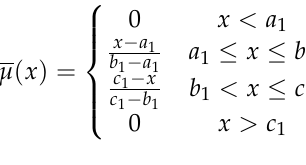
Figure 4. ScaleTriScaleGaussT3MF used in the IT3FDE. The interval type-3 triangular membership function, (cid:101) µ A ( x , u ) = ScaleTriScaleGaussT3MF, with triangular FOU ( A ) , is characterized with parameters [ a 1 , b 1 , c 1 ] (UpperParameters) for upper membership function (UMF) and λ (LowerScale), (cid:96) (LowerLag) parameters for lower membership function (LMF), to form the domain of uncertainty (DOU) with parameters ( u ) characterize the FOU ( A ) , these are IT2-FSs DOU = [ µ ( x ) , µ ( x ) ]. The vertical slices A ( x ) ( u ) with parameters [ σ ( x )] for the UMF and LMF λ (Lower- with Gaussian T2 MF, µ A ( u , m x ) Scale), λ (LowerLag). The (cid:101) µ A ( x , u ) = ScaleTriScaleGaussT3MF(x,{{[a1, b1, c1]}, λ , [ (cid:96) 1 , (cid:96) 2 ] } is described by the following Equations (31) and